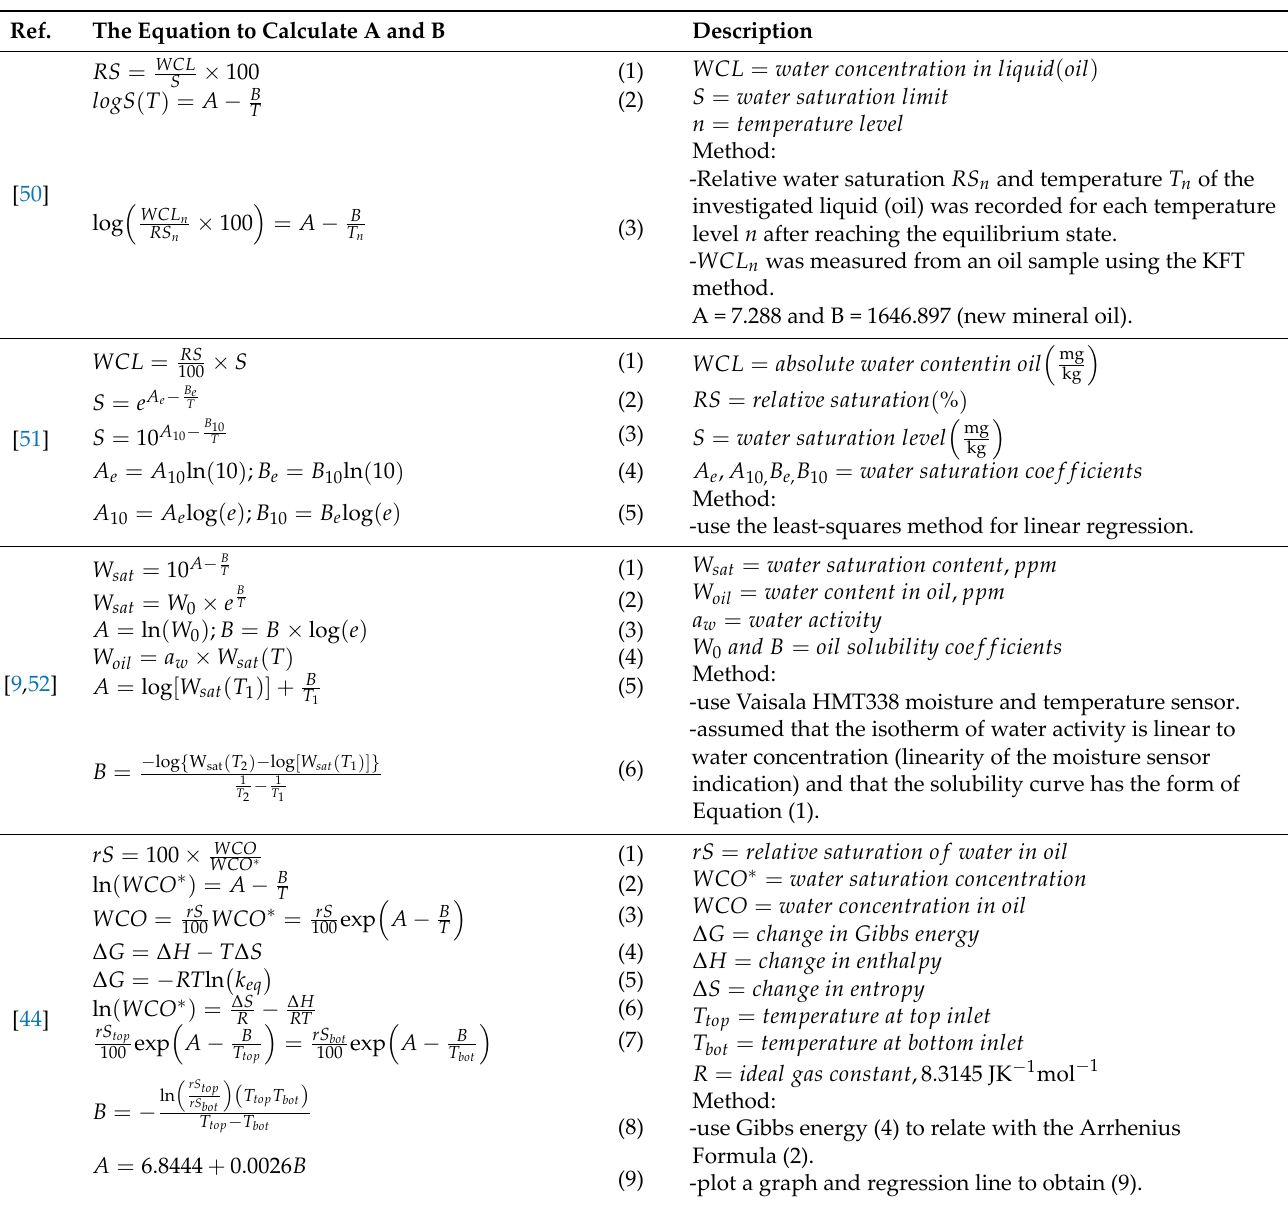
Table 5. Equation to calculate A and B coefficients from the previous